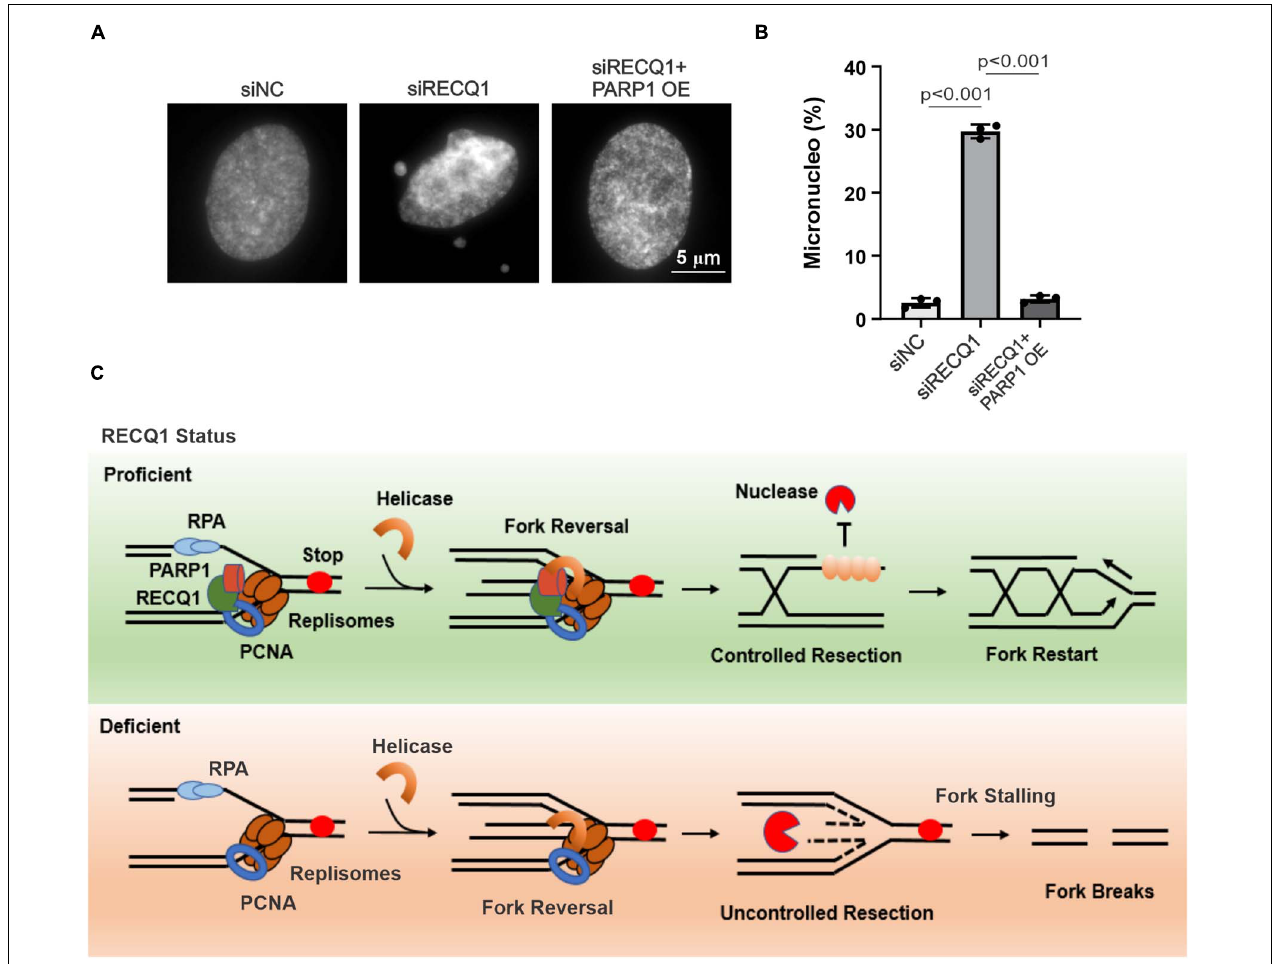
FIGURE 7 | RECQ1 deficient glioblastoma cells raised genomic instability. (A) Chromosomal abnormalities were showed by micronucleus formation in M059K cells treated with siRECQ1. (B) Quantification are represented as means ± SD from at least three independent experiments. (C) Model of RECQ1-PARP1 function. A two-sided unpaired t -test was used to calculate P -values. Significant: p < 0.05; NS, not significant: P >